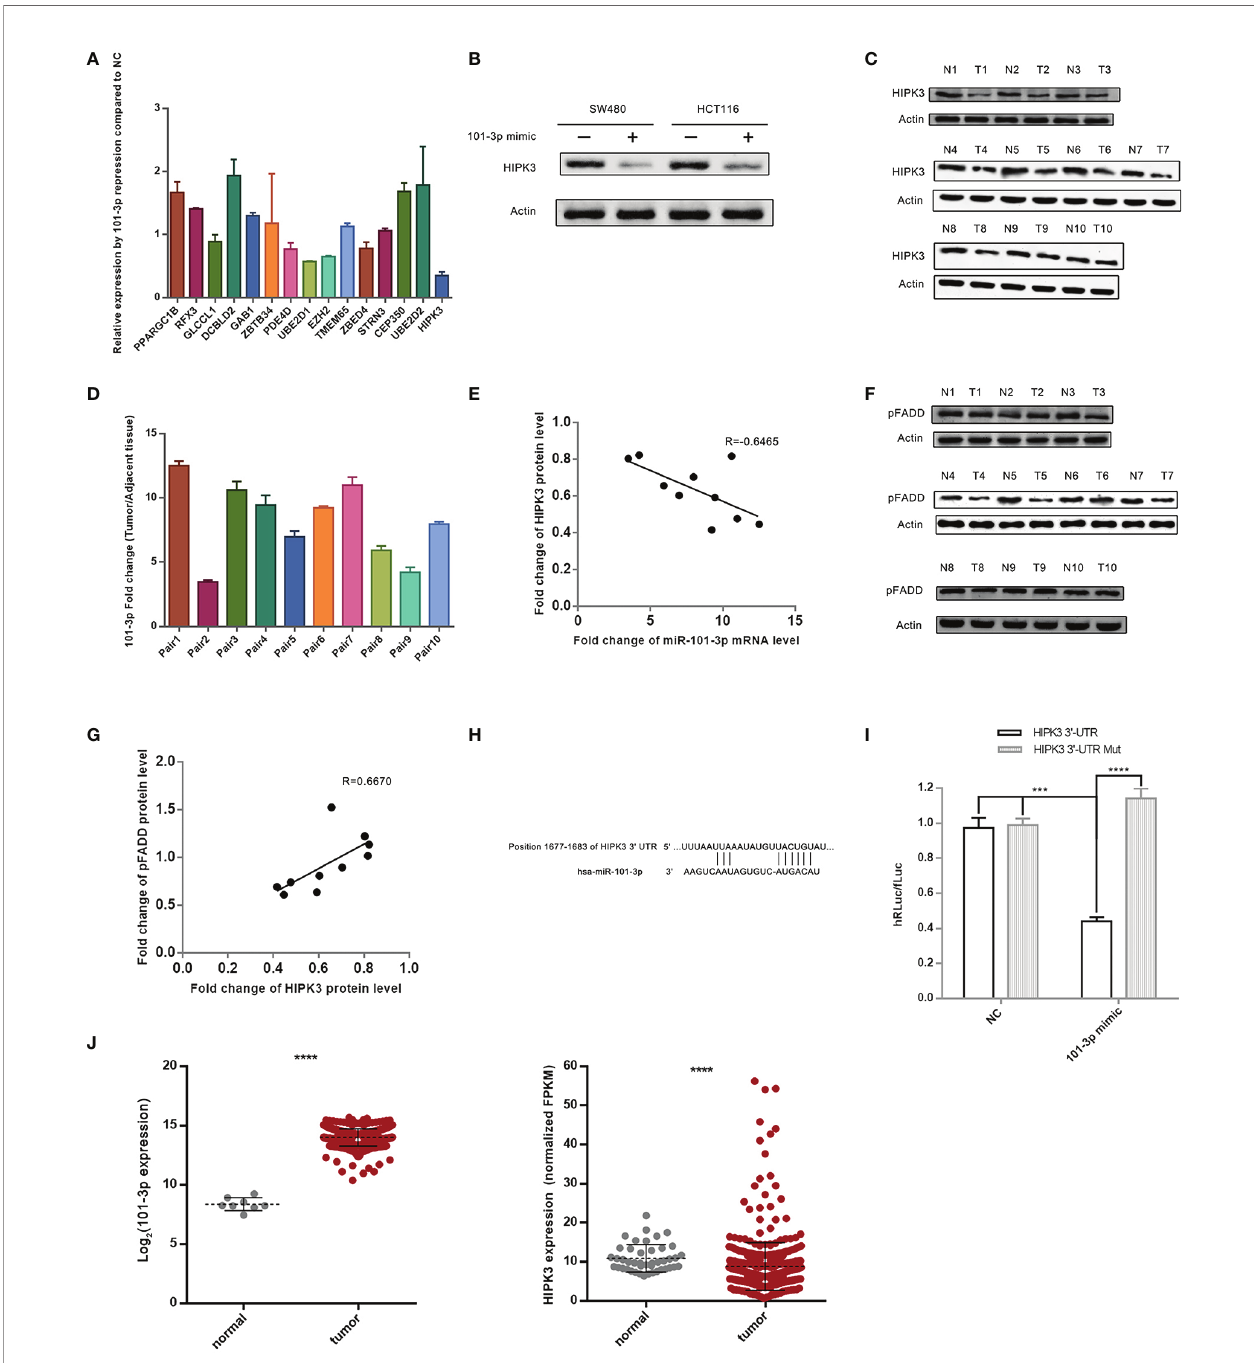
FIGURE 2 | HIPK3 is the target gene of 101-3p. (A) Relative expression level of 15 fi nal screened genes in HCT116 following transfection by 101-3p mimic. (B) Reduction of HIPK3 at the protein level by 101-3p in both HCT116 and SW480. (C) Protein level of HIPK3 in clinical tissue samples. (D) Fold change of 101-3p in clinical tissue samples (10 pairs, tumor vs . paracancerous tissue). (E) Pearson correlation plot of HIPK3 and 101-3p. (F) Protein level of phosphorylated FADD (pFADD) in clinical tissue samples. (G) Pearson correlation plot of HIPK3 and pFADD. (H) Textual representation of the fragment of HIPK3 3 ’ -UTR containing 101-3p binding site. (I) Dual-reporter luciferase assay using wild type or mutated 101-3p binding site sequence. Please refer to the methods and materials section for details. (J) 101-3p and HIPK3 expressions of deposited data of clinical samples from CRC patients in the TCGA database. **** correspond to a p-value less than 0.0001. *** correspond to p-value less than